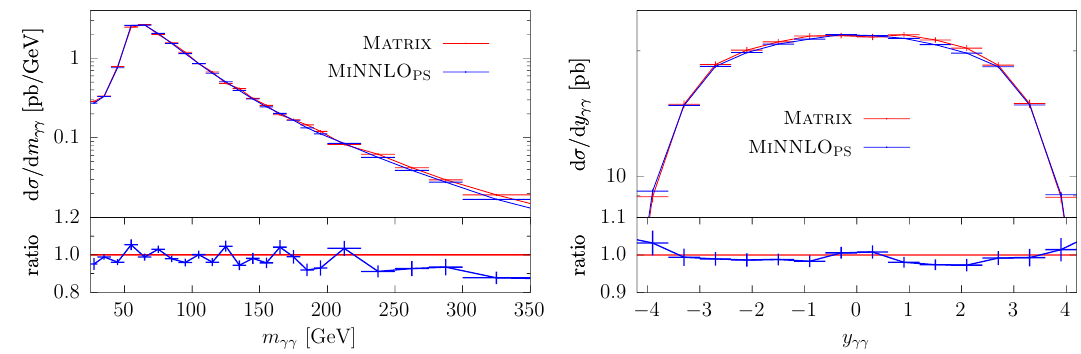
Figure 2 . Comparison between fixed-order results from Matrix and MiNNLO PS for the diphoton invariant mass and rapidity, for the default central value of the renormalization and factorization scales. The statistical errors are also